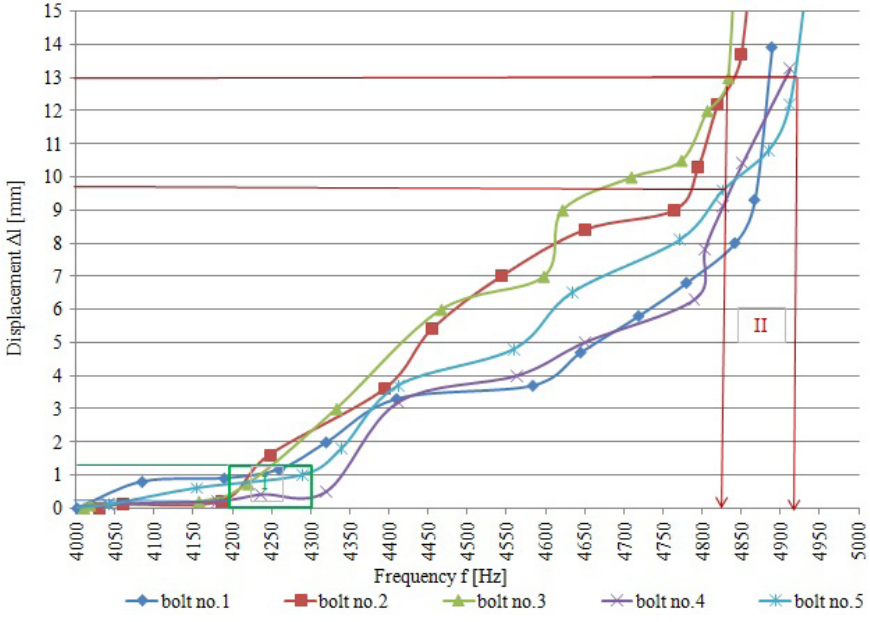
Figure 10: Displacement and frequency behavior of the expansion-shell bolt with a length of 1.82